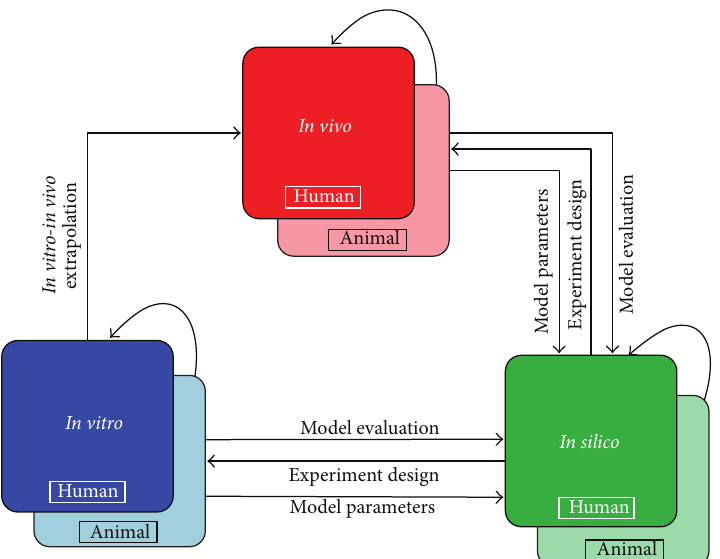
Figure 1: Schematic representation of information flow between complementary approaches, in vitro , in vivo , and in silico , in a framework aiming to support biological understanding of toxicodynamic processes in humans and model